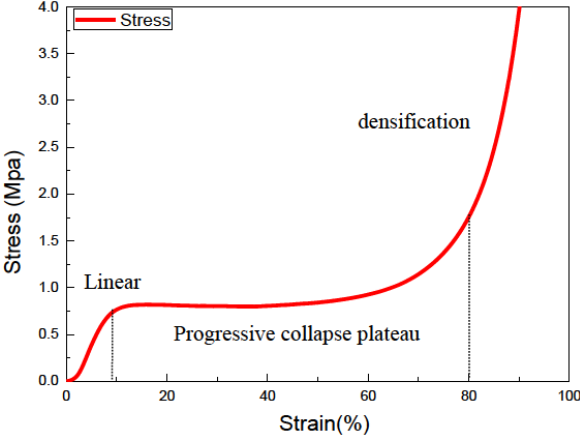
Figure 5: Stress-strain curve for a compression test on